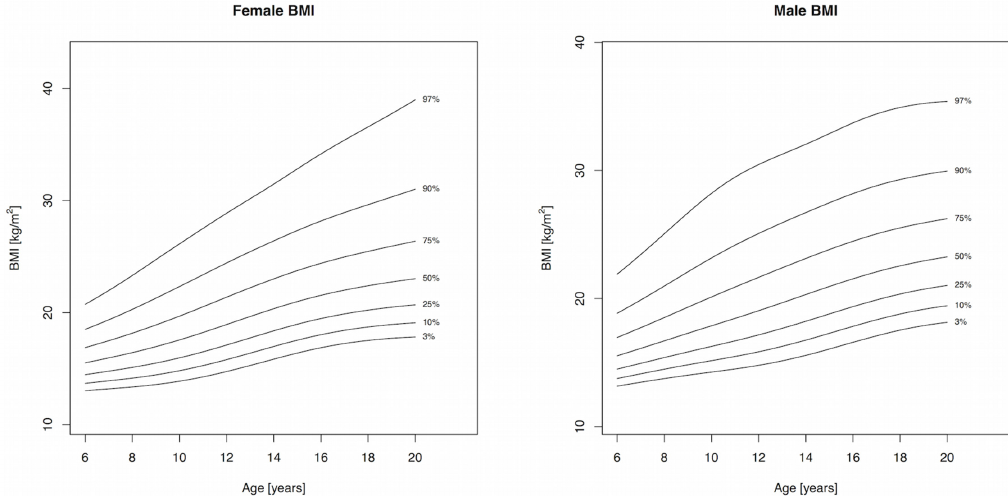
Fig 1. Percentile curves for body mass index for male and female Canadian children and youth aged 6 to 19 years.